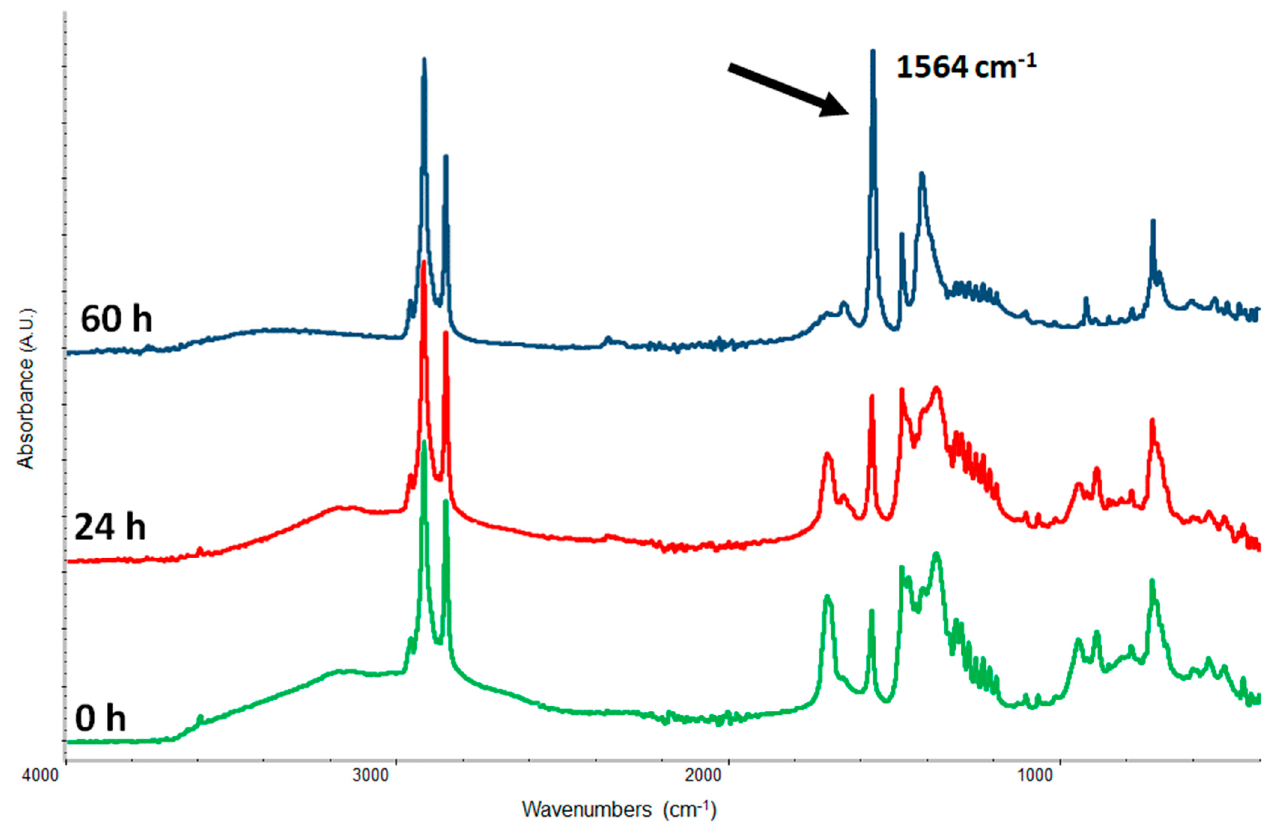
Figure 3. Kinetics of potassium carboxylate formation from a mixture 1:1 ( w / w ) of palmitic acid and KOH. The black arrow shows the carboxylate band centered at 1564 cm − 1 .